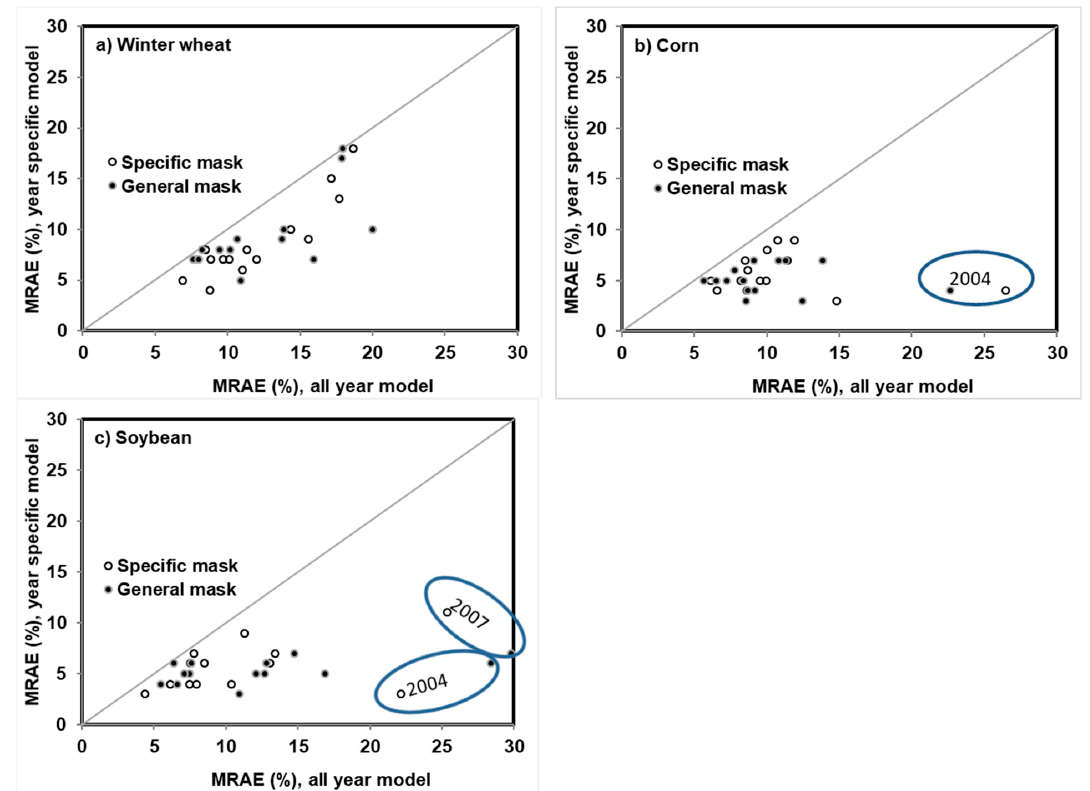
Figure 9. Comparison of yield estimation error, that is, mean relative absolute error (MRAE, %), using 250 m MODIS EVI2 using year-specific models and an all-year model. EVI2 was extracted using a general cropland mask and crop-specific mask for 2003–2016. The circles show the results of the years when there is a large difference between the all-year model and the year-specific model using the general cropland mask.